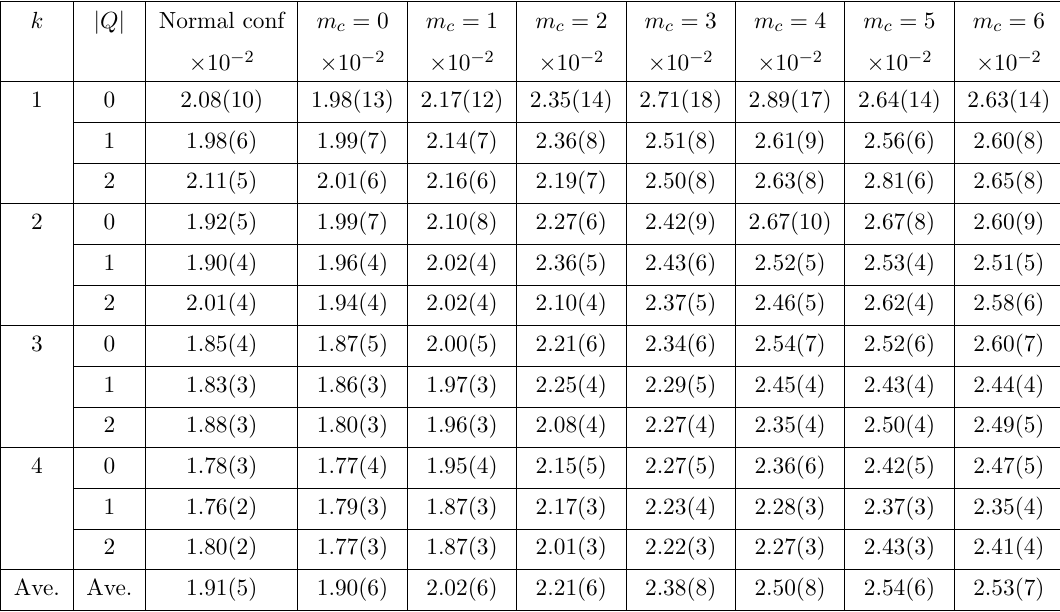
Table 8 . The results of the scale parameter (cid:6) a in the [GeV 3 ] unit. Ave. indicates the average value calculated using all the results of the k -th eigenvalues and the topological charge sectors j Q j . the distribution of the eigenvalues. This scale parameter linearly increases with increasing values of the magnetic charges m . These results correspond exactly to the results in c